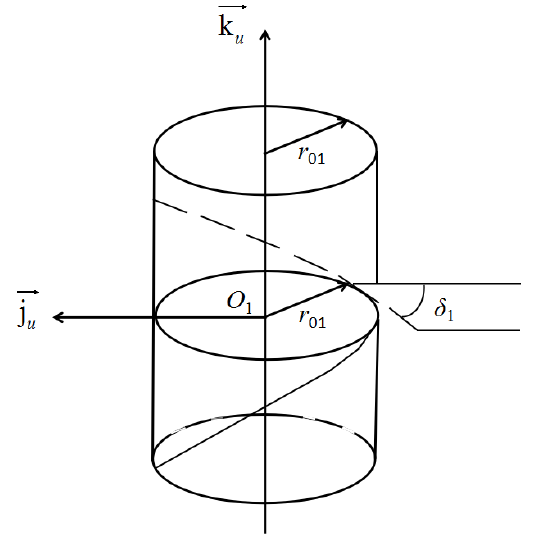
Figure 4. Schematic representation of a processed worm. Two coordinate systems are selected. The coordinate system of the cutter is ∑ U , and the coordinate system is ∑ . The positions of the cutter line edge in, ∑ U as shown in 1 Figure 5. The equation of P is given